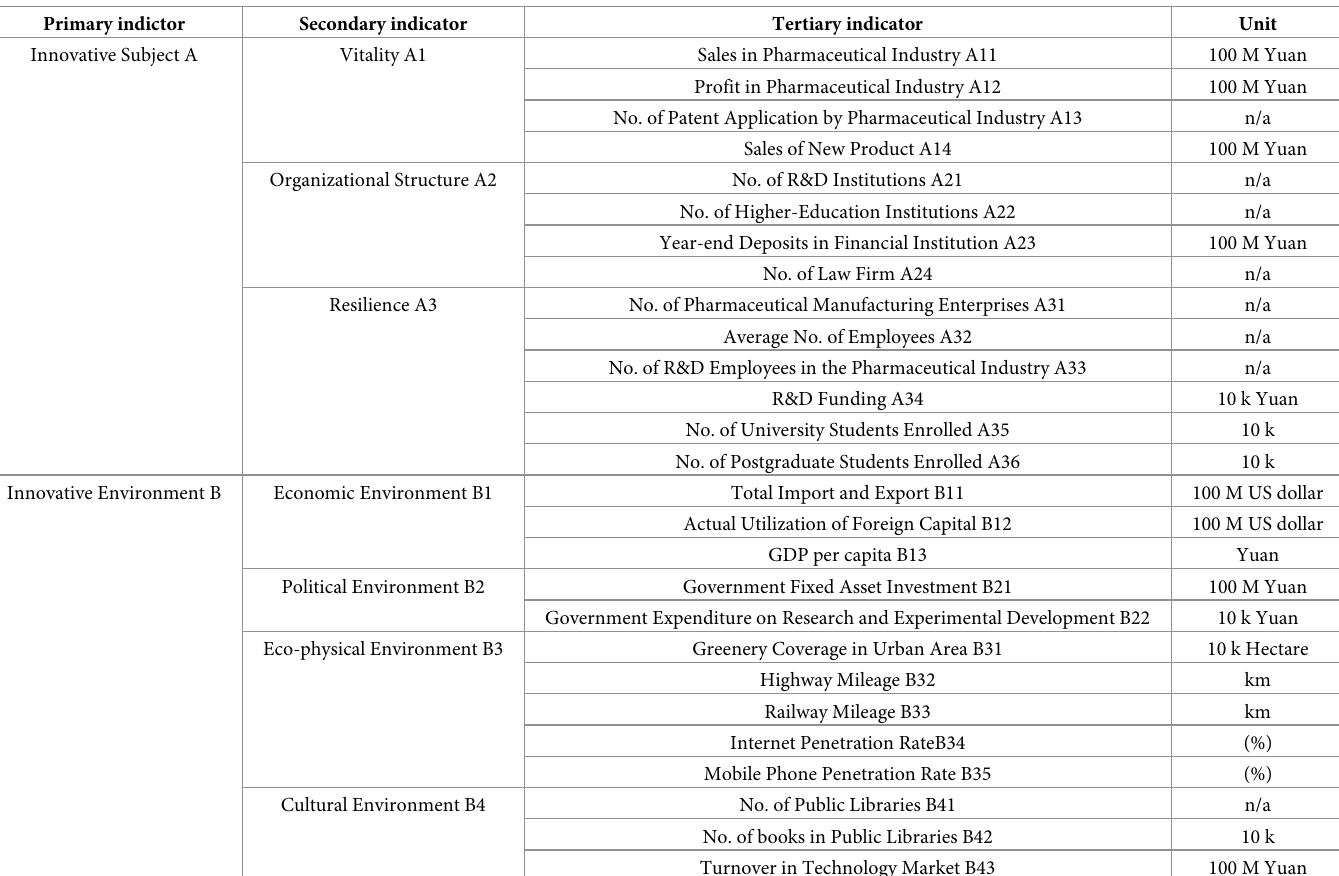
Table 1. Health assessment index system for pharmaceutical